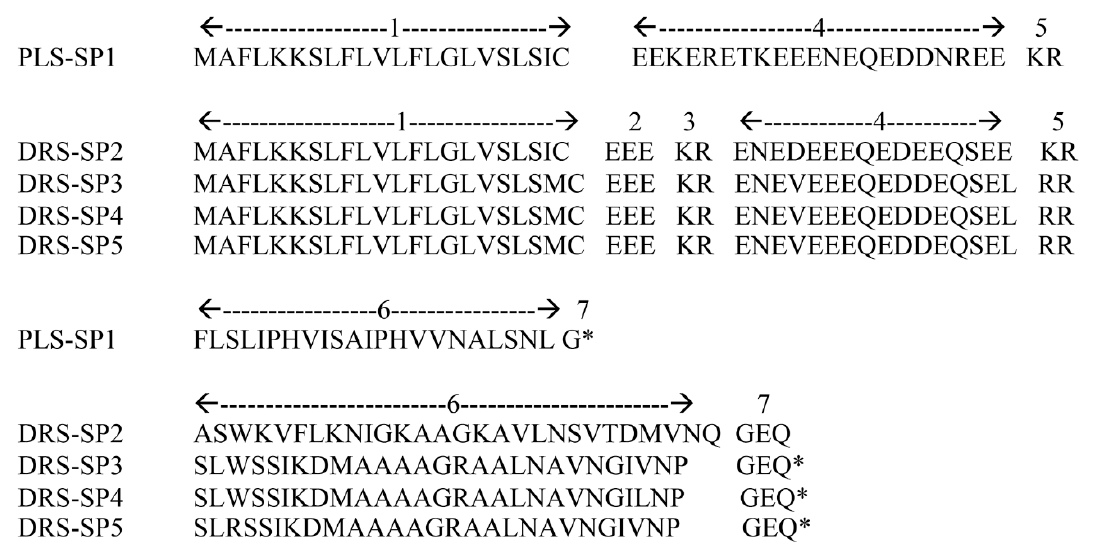
Figure 2. Translated open reading frame amino acid sequences of phylloseptin-SP1 (PLS-SP1) and dermaseptin-SP precursors (DMS-SP2-SP5). Precursor domain structures: ( 1 ) Putative signal peptides. ( 2 , 4 ) Acidic spacers. ( 3 , 5 ) Dibasic propeptide convertase processing sites. ( 6 ) Mature peptides. 7 Glycine amide donors.